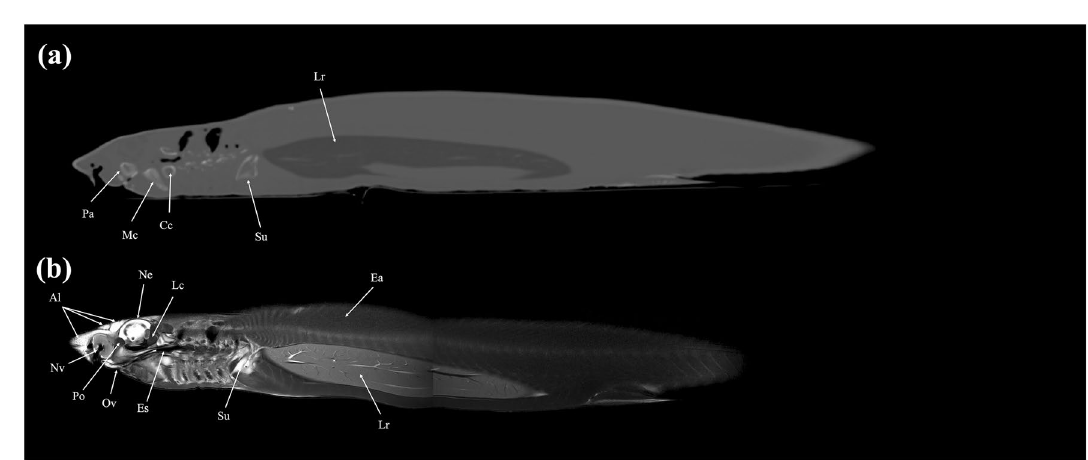
Figure 17. Sagittal ( a ) CT and ( b ) MR images of a banded houndshark ( Triakis scyllium ) at level 17 of Fig. 25. Al Ampullae of Lorenzini, Am Adductor mandibularis, Ba Basihyal cartilage, Cc Ceratohyal cartilage, Es Esophagus, Hc Hyomandibular canal, Ic Infraorbital canal, Io Inferior obliquus, Lc Levator cranium maxillae, Le Lens, Mc Meckel’s cartilage, Mp Metapterygium, Mt Mandibular teeth, Ne Neurocranium, Ni Nictitating fold, Ol Optic lobe, Op Optic nerve, Ov Oral cavity, Pa Palatoquadrate, Po Preorbitalis, Pr Posterior rectus, Sc Supraorbital canal, Su Scapular cartilage, So Superior obliquus, Th Thalamus, Ty Thyroid, Vi Vitreous